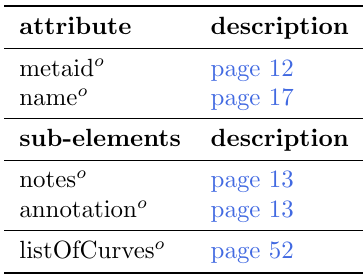
Table 2.22: Attributes and nested elements for plot2D. o denotes optional elements and attributes.